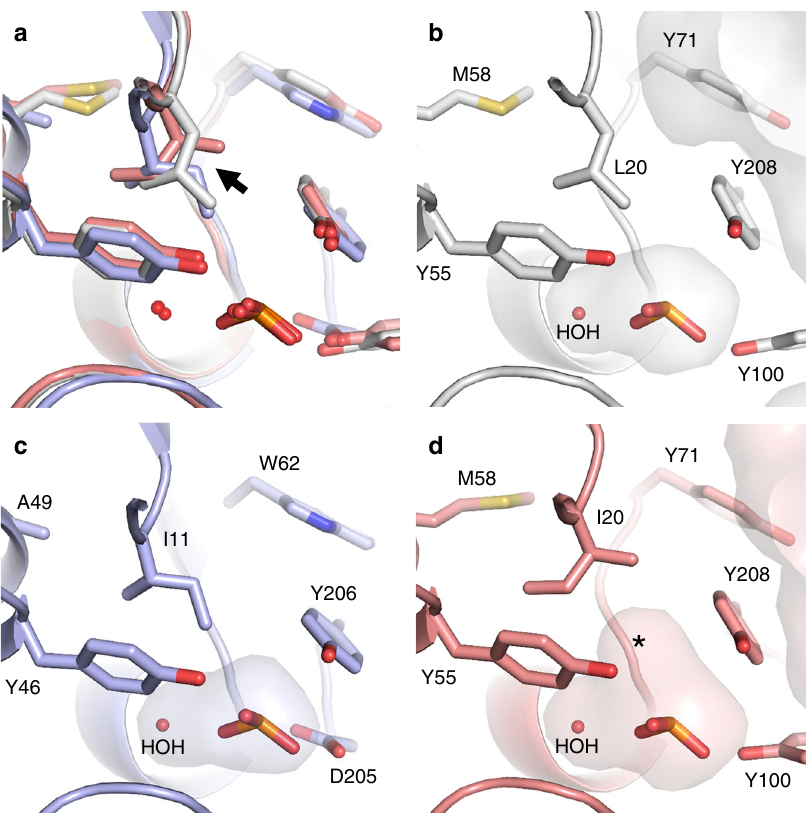
Fig. 6 The volume of the binding pocket in Pm_PtxB is ~25% bigger than that of Te_PtxB and Pm_PhnD. Superposition of the Pm_PtxB/phosphite structure (pink) with those of Te_PtxB (grey) and Pm_PhnD (blue) ( a ) shows how a sequence difference (black arrow) in the binding pocket increases the volume of the cavity in Pm_PtxB. In Te_PtxB ( b ) and Pm_PhnD ( c ) Leu20 and Ile11 (respectively) provide a hydrophobic surface for the ligand to pack against within the binding pocket. In Pm_PtxB ( d ) Ile20 adopts an alternative rotamer making the hydrophobic region of the pocket slightly larger, as indicated by the asterisk ( *